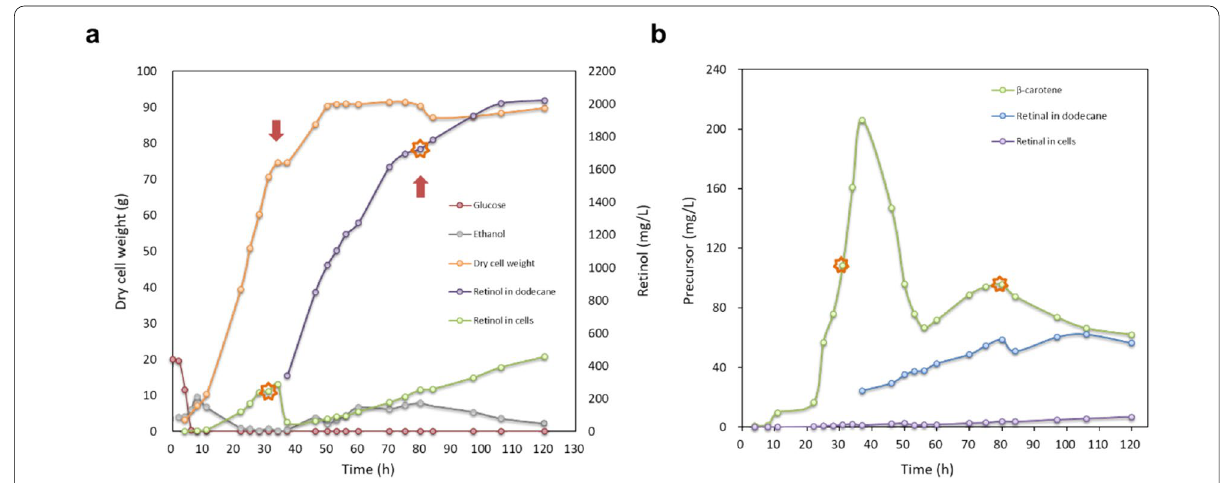
Fig. 6 Retinol production of strain Y03-43( ) in fed-batch fermentation. a Profile of glucose, ethanol, biomass and retinol accumulation. b + Accumulation of precursors. The arrows and asterisks indicate the time of adding dodecane and Fe 2 + ,